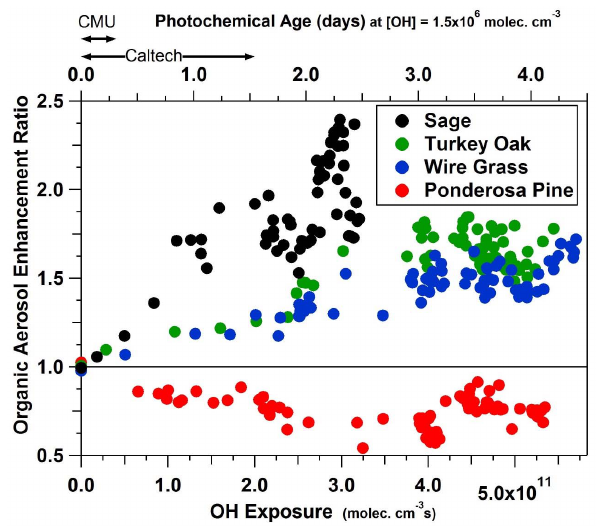
Fig. 6. OA enhancement ratio as a function of photochemical age and OH exposure for four fuels (ponderosa pine, burn 40; wire grass, burn 42; turkey oak, burn 45; and sage, burn 49). The range of OH exposure examined in smog chambers at Caltech (Chhabra et al., 2011) and Carnegie Mellon’s mobile laboratory (Hennigan et al., 2011) are shown for reference.